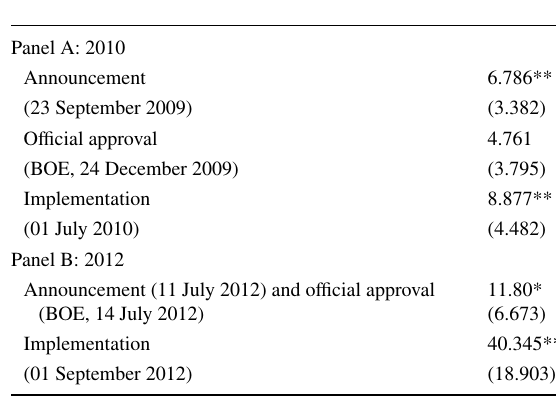
discontinuity (polynomial order 4): VAT reforms impact on Google searches for keyword